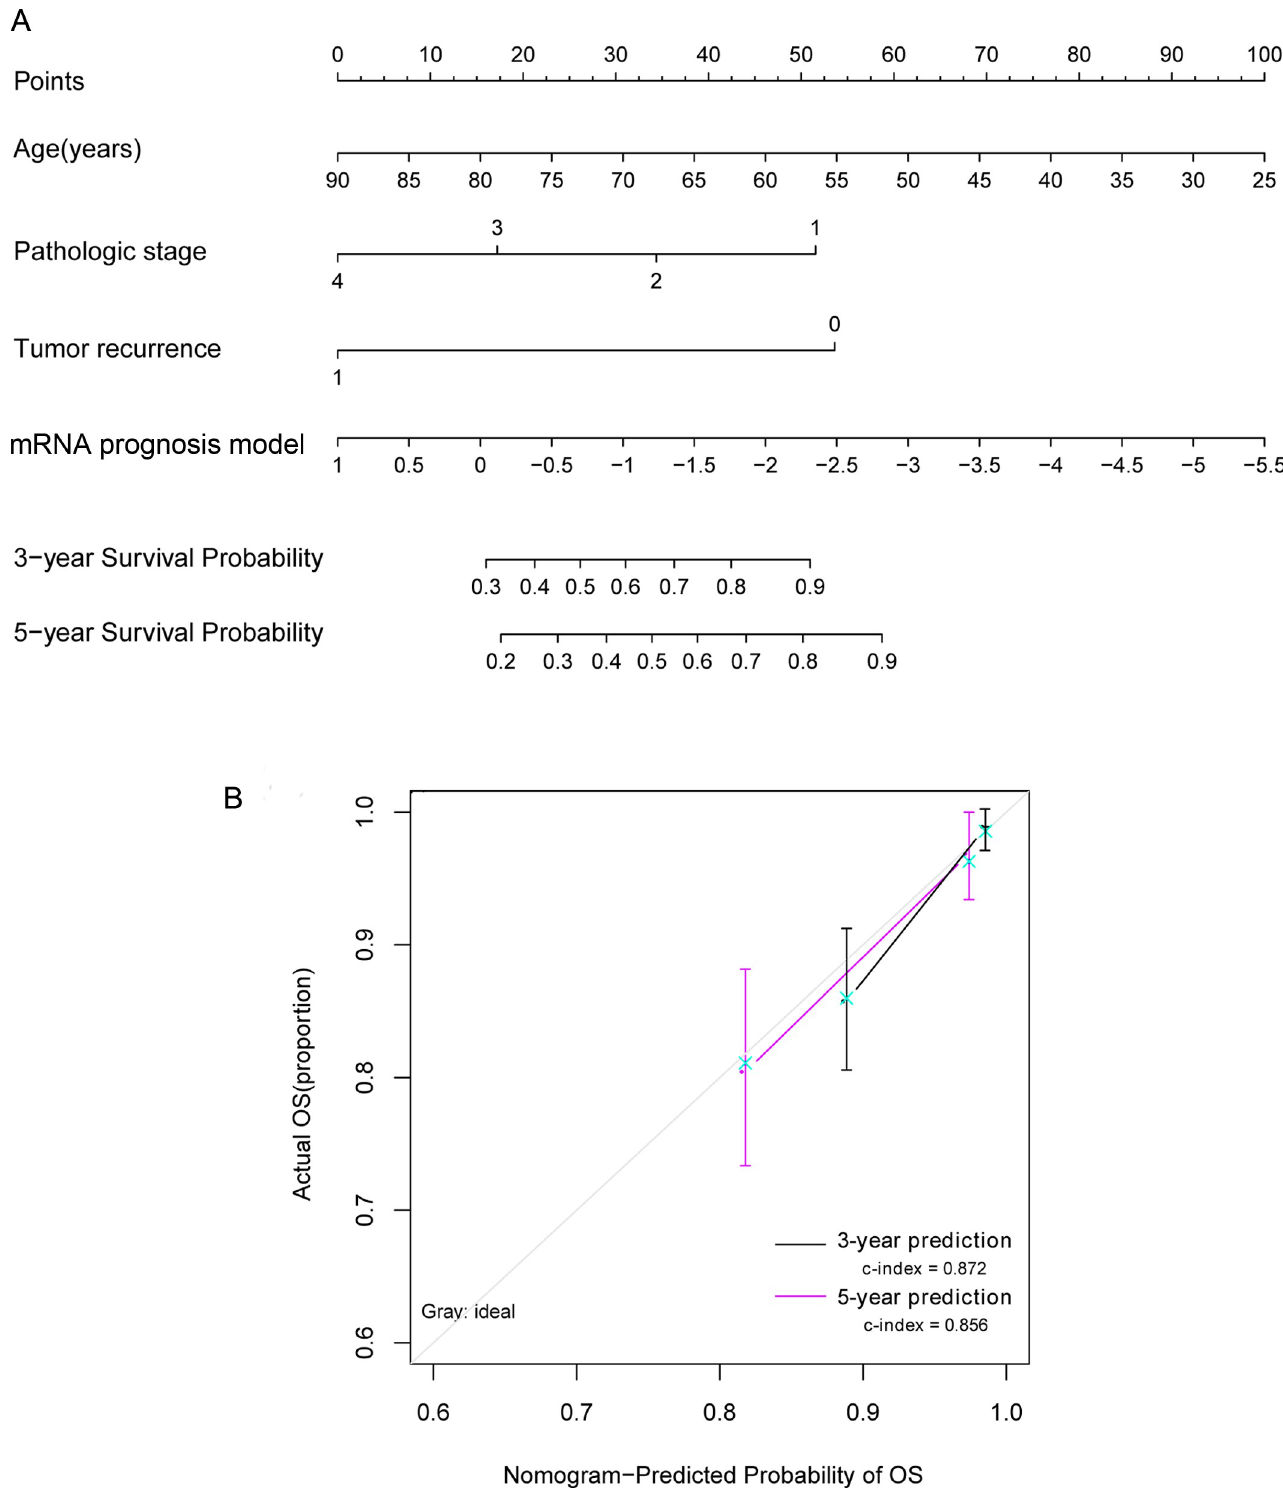
Fig 5. The prognostic nomogram model for independent prognostic factors and three-year and five-year survival prediction. (A) Nomogram of a prognostic model for independent prognostic factors. (B) Line chart of three-year and five-year survival predictions and actual survival. The horizontal axis represents the predicted OS rate, the vertical axis represents the real OS rate, and black and red represent the three-year and five-year forecast line graphs, respectively. OS, overall survival. c-index, concordance index.